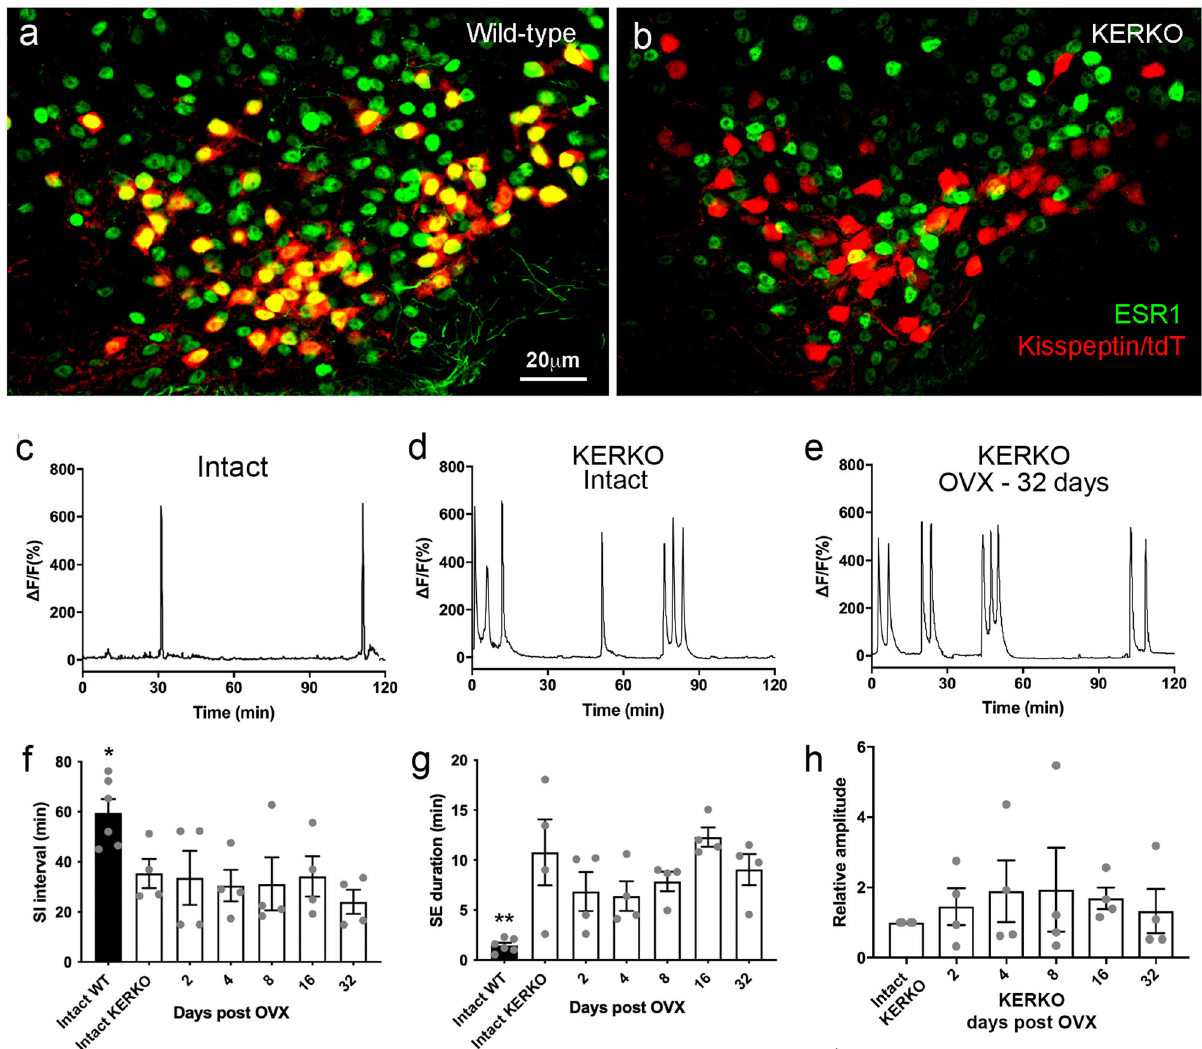
Fig.4 |GnRHpulsegeneratoractivityinKiss1-speci fi cESR1knockout(KERKO) mice. a , b Representative examples of dual-label immuno fl uorescence for tdT (kisspeptin) and ESR1 (green) in wild-type ( a , N =4) and KERKO ( b , N =5)) mice. Almost all tdT neurons co-express ESR1 (yellow nuclei) while none occur in the KERKOmouse. c Representativeexampleof GCaMP6photometryrecordingsfrom an intact mouse wild-type at the Esr1 locus. d , e photometry recordings from